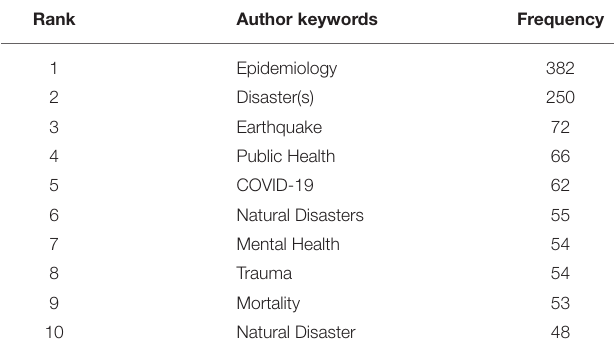
TABLE 3 | Top 10-most relevant